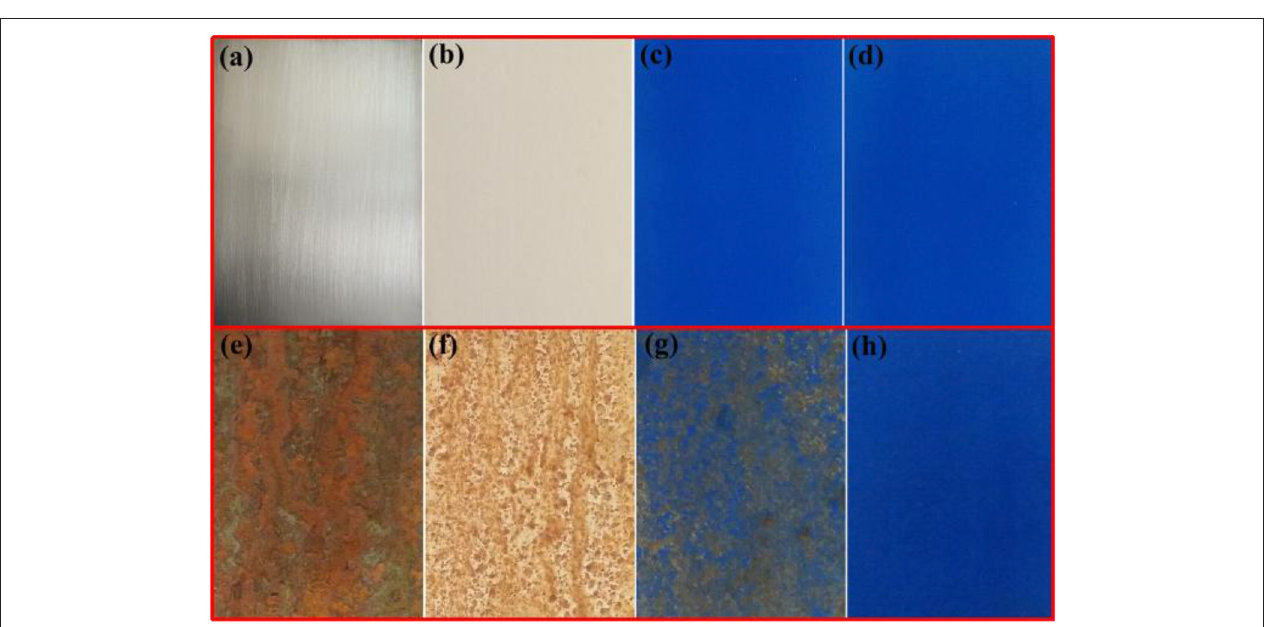
FIGURE 5 | Photographs of (a) steel substrate, (b) steel coated the paint without pigment, (c) steel coated the paint containing commercial CoAl 2 O 4 , (d) steel coated the paint containing hybrid pigment. (e–h) Their corresponding images after being exposed to salt spray test for 60 days, respectively.